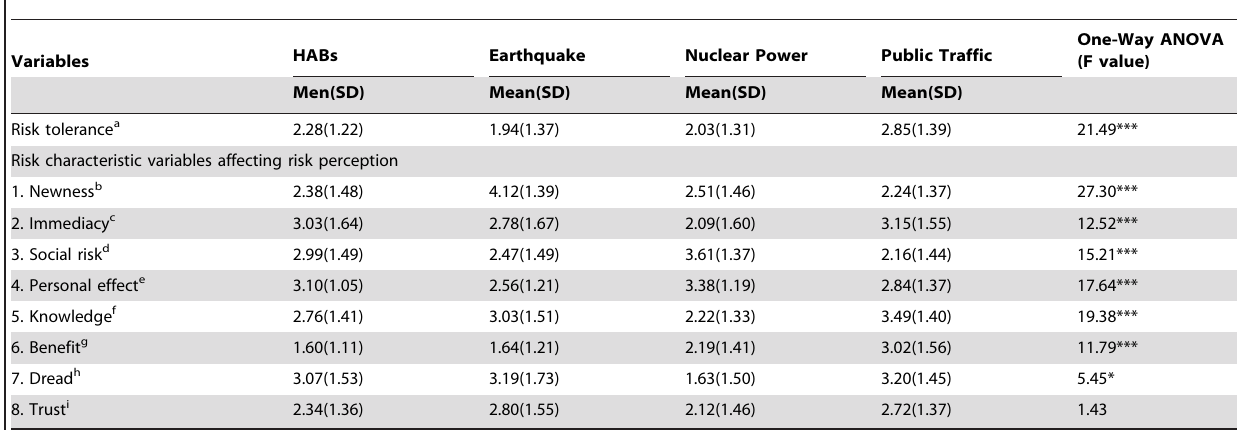
Table 3. Descriptive Statistics of the Risk Characteristic Variables of Four Kinds of